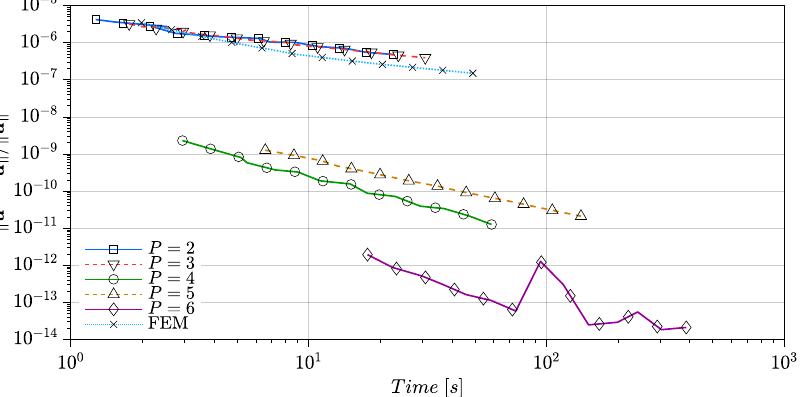
Figure 6. Error vs time (the lower the better), allowed by different values of P , Ω : sphere, b.c.: Dirichlet, N > 20k nodes.